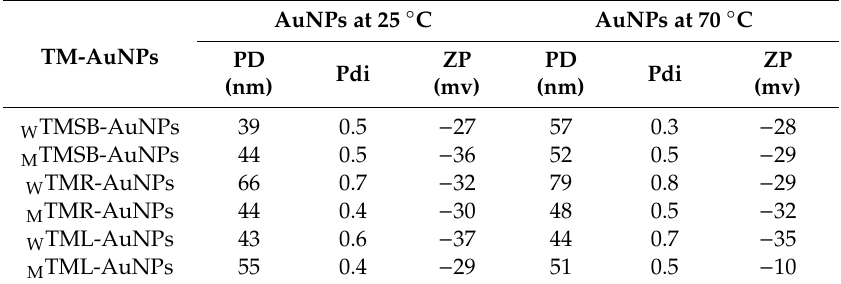
Table 3. Dynamic light scattering (DLS) analysis of TM-AuNPs synthesized at 25 and 70 ◦ C. AuNPs at 25 ◦ TM-AuNPs